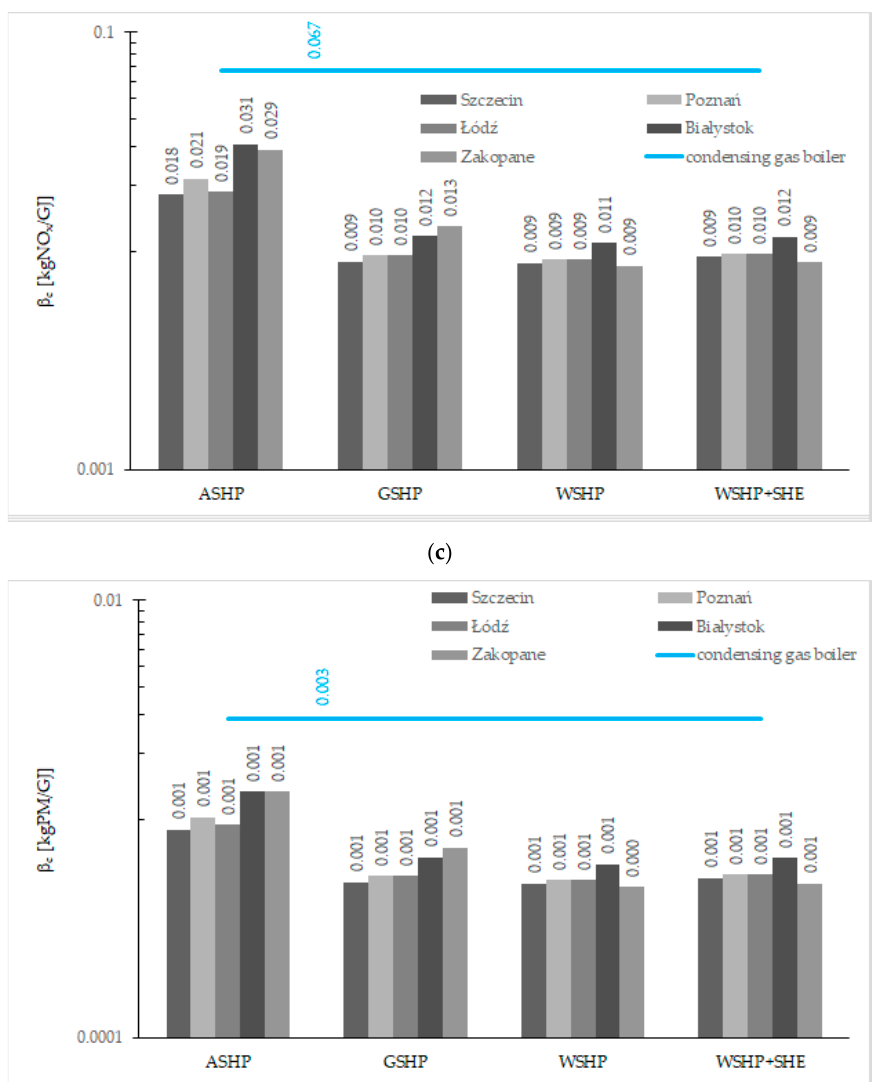
Figure 4. The outcomes for 3rd scenario; unit emissions of greenhouse gases and particulate matter for the heat pumps in the specific locations determined for the variant with changed temperature in the buffer tank as well as unit emissions of condensing gas boiler as a reference level: ( a ) carbon dioxide; ( b ) sulfur dioxide; ( c ) nitrogen oxide; ( d ) particulate matter.